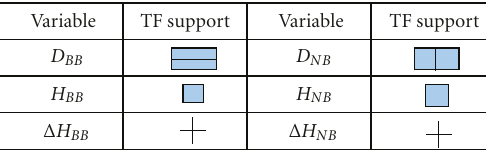
Figure 3: Cartoon summarizing TF support of statistical features.